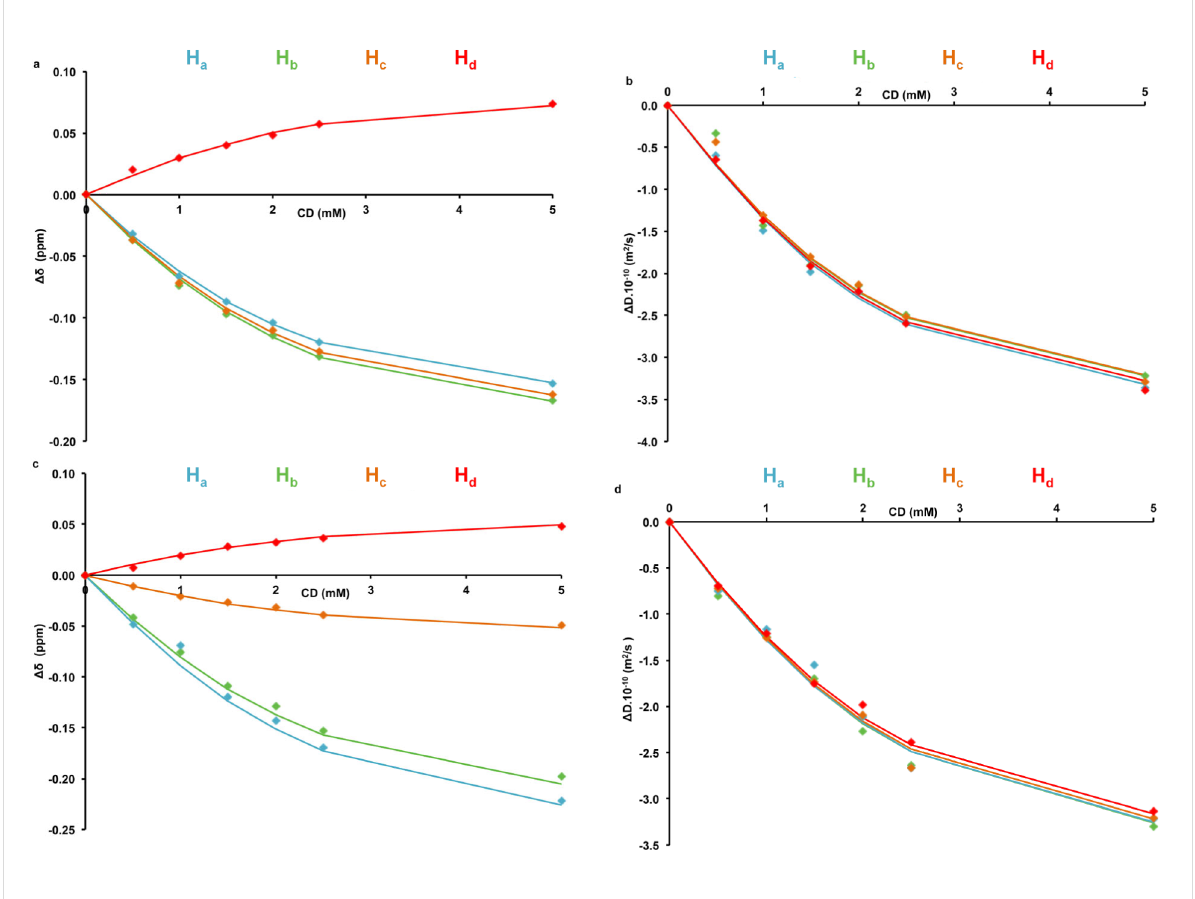
Figure 4: Representation of chemical shifts variations ( Δδ ) of a) carvacrol ( 1) and c) thymol ( 2) protons and diffusion coefficients variations ( Δ D) of b) carvacrol ( 1) and d) thymol ( 2) protons with various β -CD concentrations. Experimental results are represented as filled diamonds and theoretical data are illustrated as solid